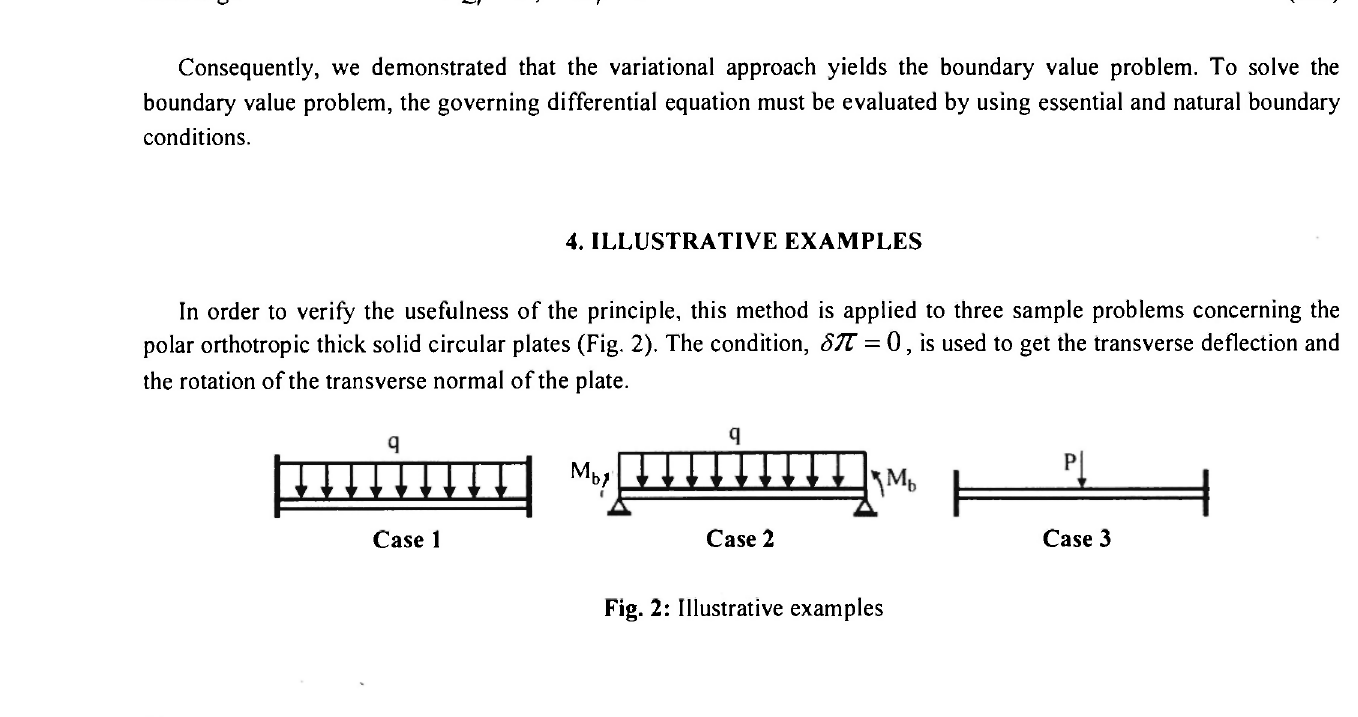
Fig. 2: Illustrative